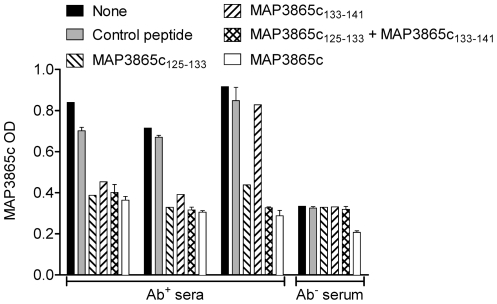
Ab reactivities against the MAP3865c protein are inhibited by MAP3865c125–133 and MAP3865c133–141 peptides.Ab+ and Ab-negative sera from T1D patients were pre-incubated overnight with saturating concentrations (5.5 µM) of MAP3865c125–133, MAP3865c133–141, the two peptides in combination, MAP3865c-MBP fusion protein and control or no peptide. Their reactivity on MAP3865c-MBP-coated ELISA plates was subsequently tested. Bars depict means ± SEM of triplicate wells and results are representative of three separate experiments.